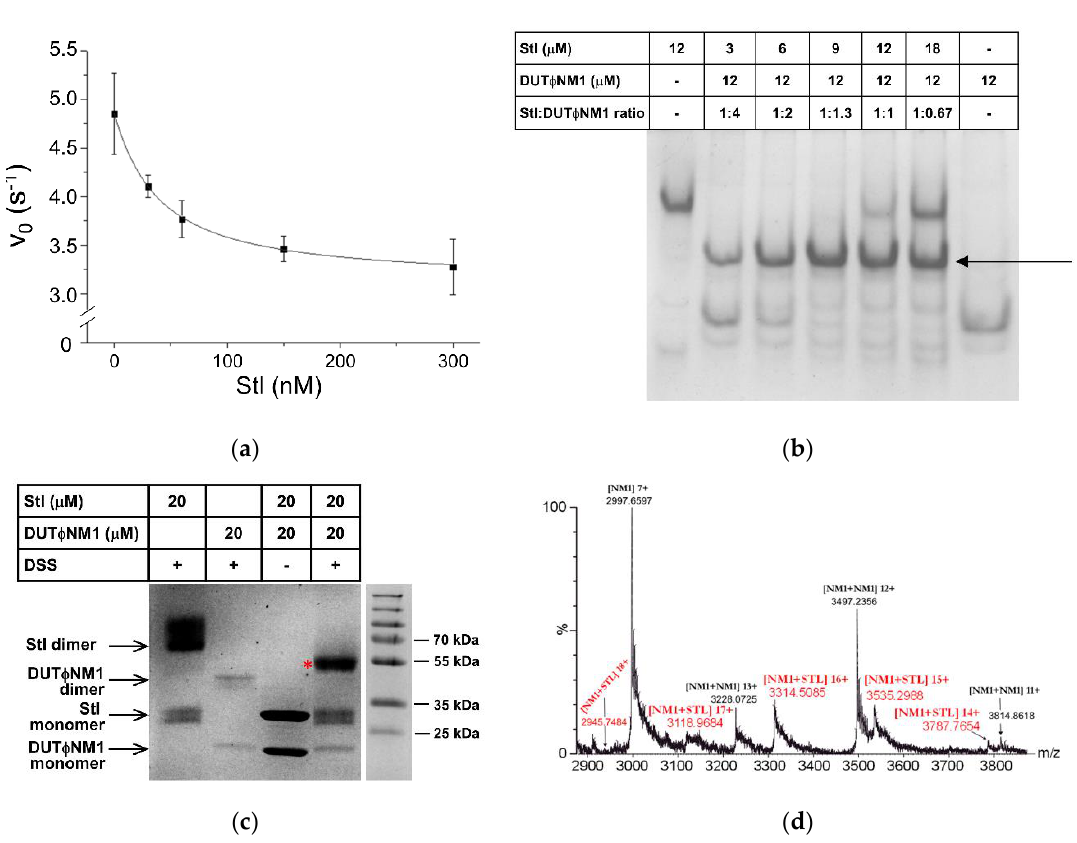
Figure 2. Biophysical characterization of ϕ NM1 phage dUTPase-Stl interaction. ( a ) Enzyme activity of homodimeric DUT ϕ NM1 in the presence and absence of Stl (steady-state conditions). The maximal extent of inhibition was about 40%, the binding is characterized by the apparent inhibitory constant of K i, app = 34 ± 14 nM. ( b ) Native gel electrophoresis of Stl, DUT ϕ NM1 and the mixture of the two proteins of various molar ratios, species, and concentrations of monomers are indicated in the figure. Note the emerging band (indicated by arrow) in the samples containing the mixture of the two proteins that suggests the formation of an Stl-DUT ϕ NM1 heterodimer, situated between the bands of the individual dimeric proteins. ( c ) SDS-PAGE analysis of Stl, DUT ϕ NM1, and their mixture after chemical crosslinking induced by the reagent disuccinimidyl suberate (DSS). The mixture of the untreated proteins was also loaded on the gel as a control. The band corresponding to the molecular mass of the DUT ϕ NM1-Stl heterodimer is denoted with a red star. ( d ) The native mass spectrum of the DUT ϕ NM1-Stl mixture. Peak series with m / z values of 2946 (18 + ), 3119 (17 + ), 3315 (16 + ), 3535 (15 + ), 3788 (14 + ) (highlighted in red) indicate the presence of an assembly associated with the molar mass of 53020 ± 7 Da, which corresponds to a 1:1 complex of Stl (32.0 kDa) and DUT ϕ NM1 (21.0 kDa), constituting the DUT ϕ NM1-Stl heterodimer (designated as “NM1 + Stl” on the figure). Peaks corresponding to DUT ϕ NM1 monomer (NM1) and homodimer (NM1 + NM1) are also present in the